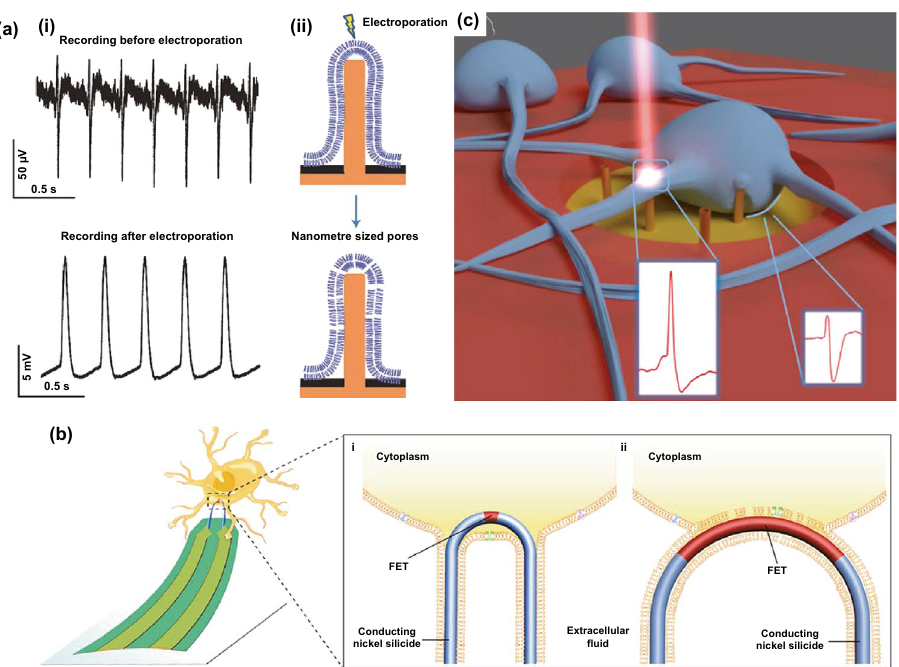
Fig. 3 a (i) Before electroporation, action potentials recorded shows extracellular signatures. After electroporation, the intracellular signal amplitude increases above 100‑fold. (ii)Schematic of the electroporation of the cell membrane by a nanopillar electrode [90]. b Diagram of